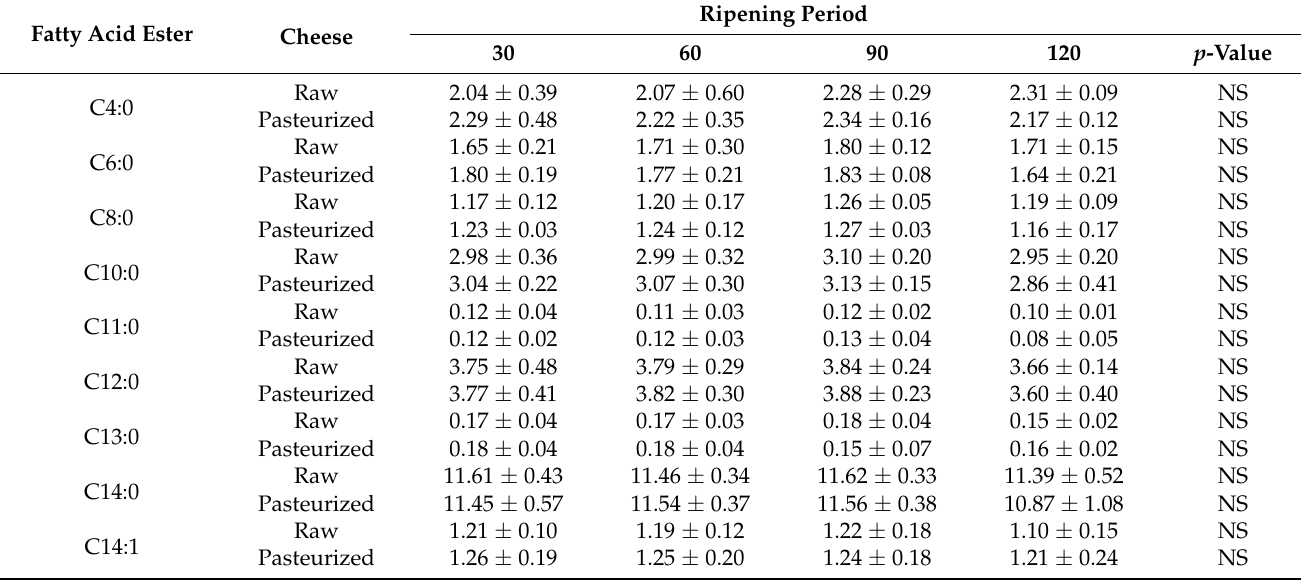
Table 5. Fatty acid composition (%) of raw and pasteurized cheese during